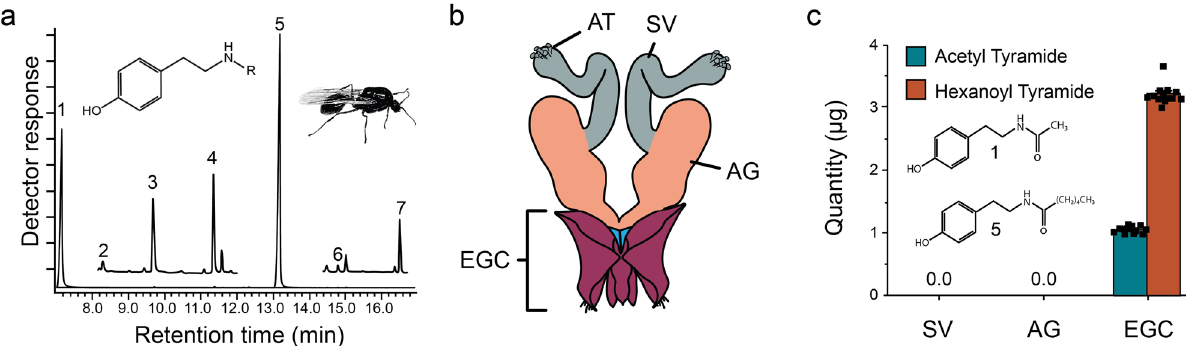
Fig. 1 Unique male tyramide chemistry. a GC-MS trace of fi re ant male produced tyramides ( 1 through 7 ), minor tyramide components (2, 3, 4, 6, 7) are shown on a reduced scale above the baseline for visualization. A general tyramide structure and a winged male are shown. b The unusual tyramide chemistry is speci fi c to the male reproductive system (AT Atrophied Testes; SV Seminal Vesicles; AG Accessory Glands; EGC External Genitalia Complex. The EB, Endophallic Bladder resides within the EGC). c Further, analyses of the three distinct male reproductive system parts for tyramides showed they are found exclusively in the EGC ( n = 13) Structures for the two major tyramide components ( 1 & 5 ) are shown. Bars represent the mean ± SEM and squares represent individual males. See Table 1 for the percent composition and quantity of the seven identi fi ed tyramides.